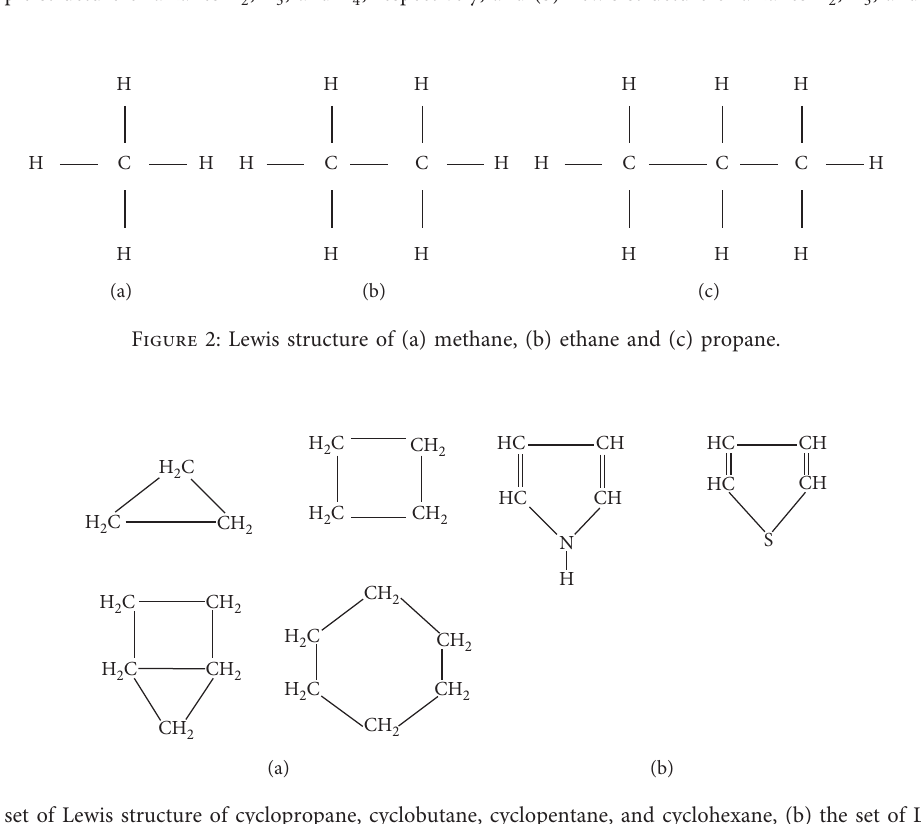
, P , and P , respectively, and (b) Lewis structure of alkanes P 2 3 4